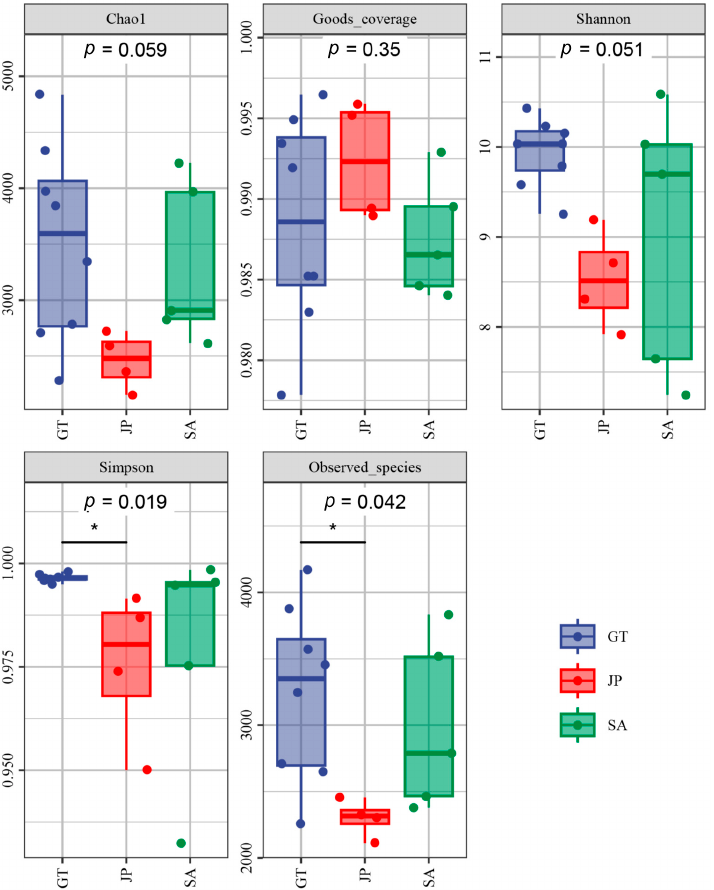
Figure 2. Five different types of indexes of soil samples form bare flats (GT), Sueada salsa areas (JP), and S. alterniflora Loisel areas (SA). The Chao1 and Observed_species indexes show community richness. The Shannon and Simpson indexes show the community diversity. Good’s coverage index shows the community coverage analysis of each sample. * indicates that there are significant differences between the two groups of data using dunn’s test.